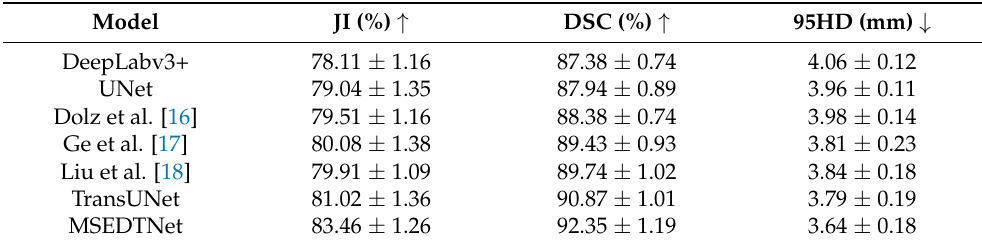
Table 4. Segmentation results of different methods.